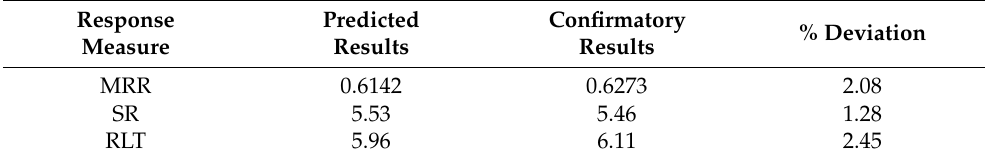
Table 6. Results of confirmatory